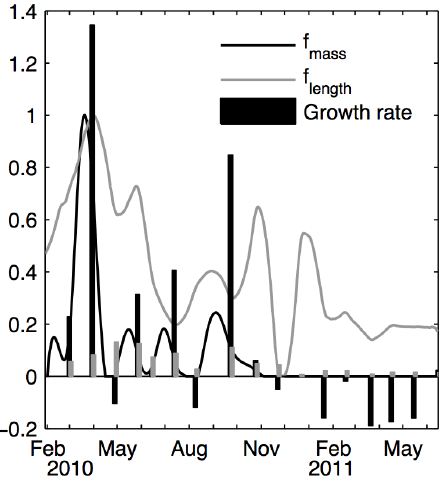
Figure 5. Comparisons of functional responses obtained with shell length (grey) and DFM (black) variation (see text for functional response computation). Bars represent the daily relative growth rates between two points. Both functional responses were standardized to vary between 0 and 1.